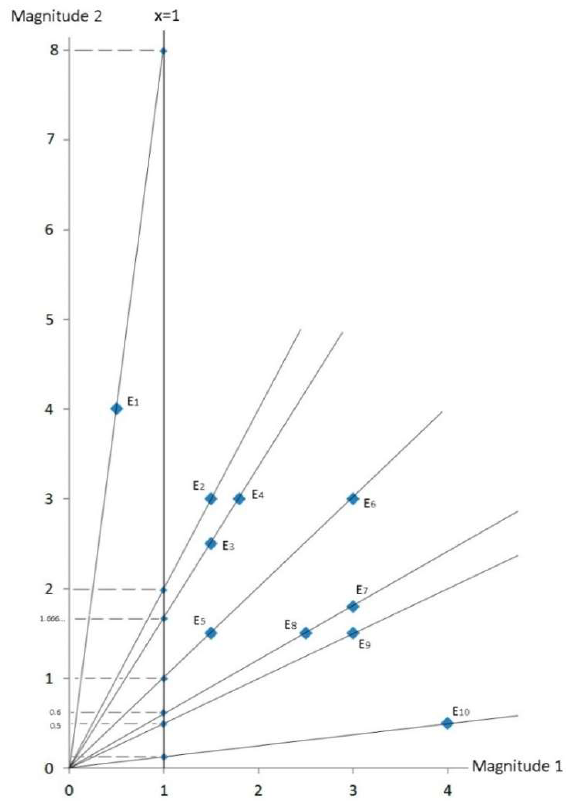
Figure 4. Graphical calculation of the ratio of the ten firms (E 1 to E 10 ) using the projection on the line x = 1.